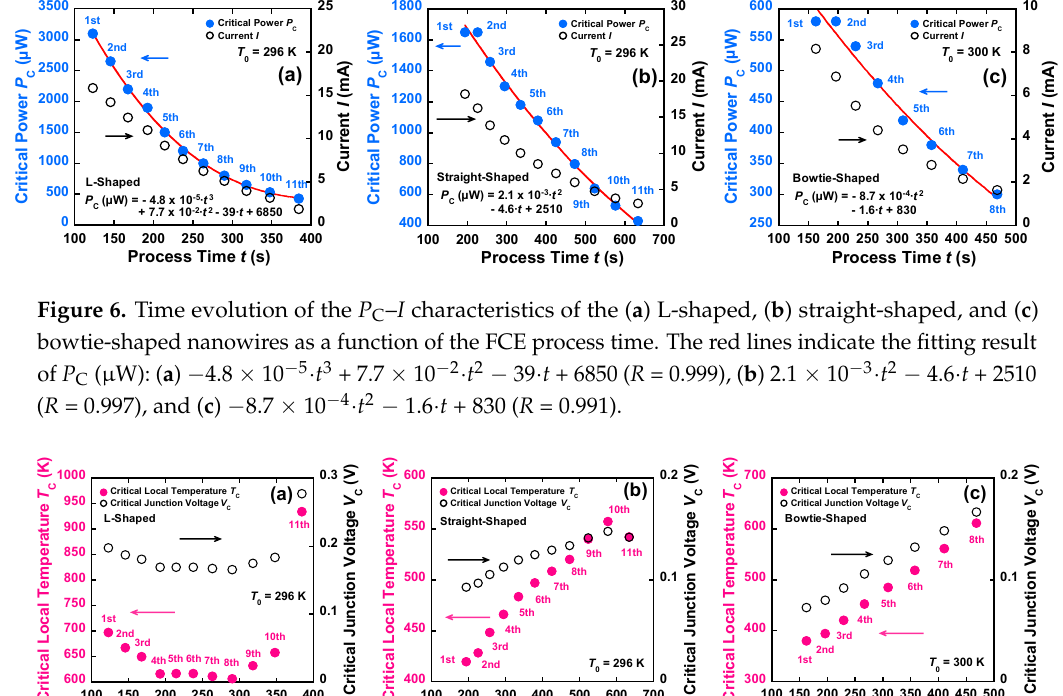
Figure 5. G as a function of the total voltage V for the ( a ) L-shaped, ( b ) straight-shaped, and ( c ) bowtie- shaped nanowires during FCE. The dashed lines indicate the fitting results of the Joule heating model.